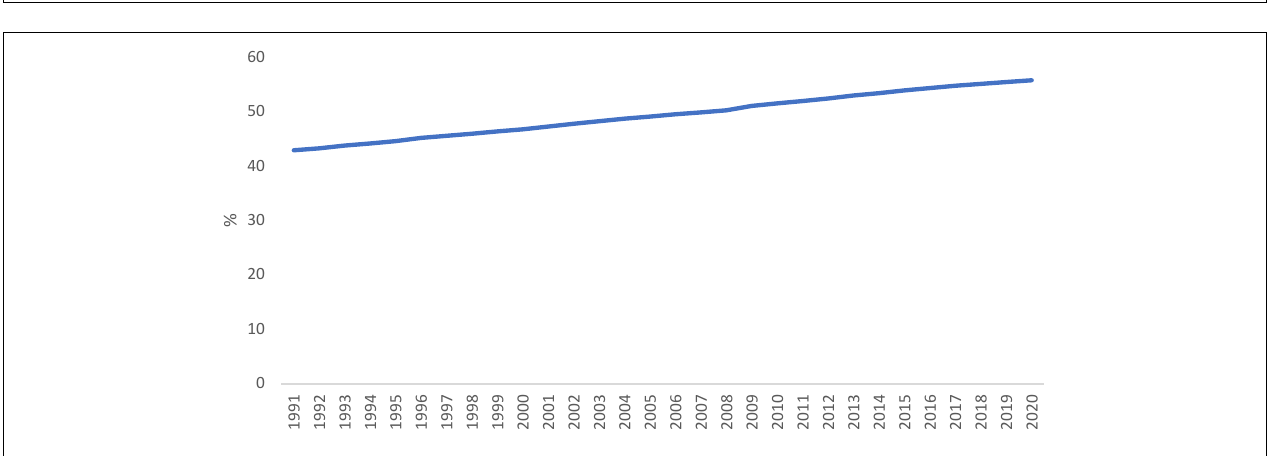
FIGURE 1 | Log service value added. Data reflect available observations from all countries for 1960–2019 and are reported in constant 2010 US $. Source: World Bank (2021).